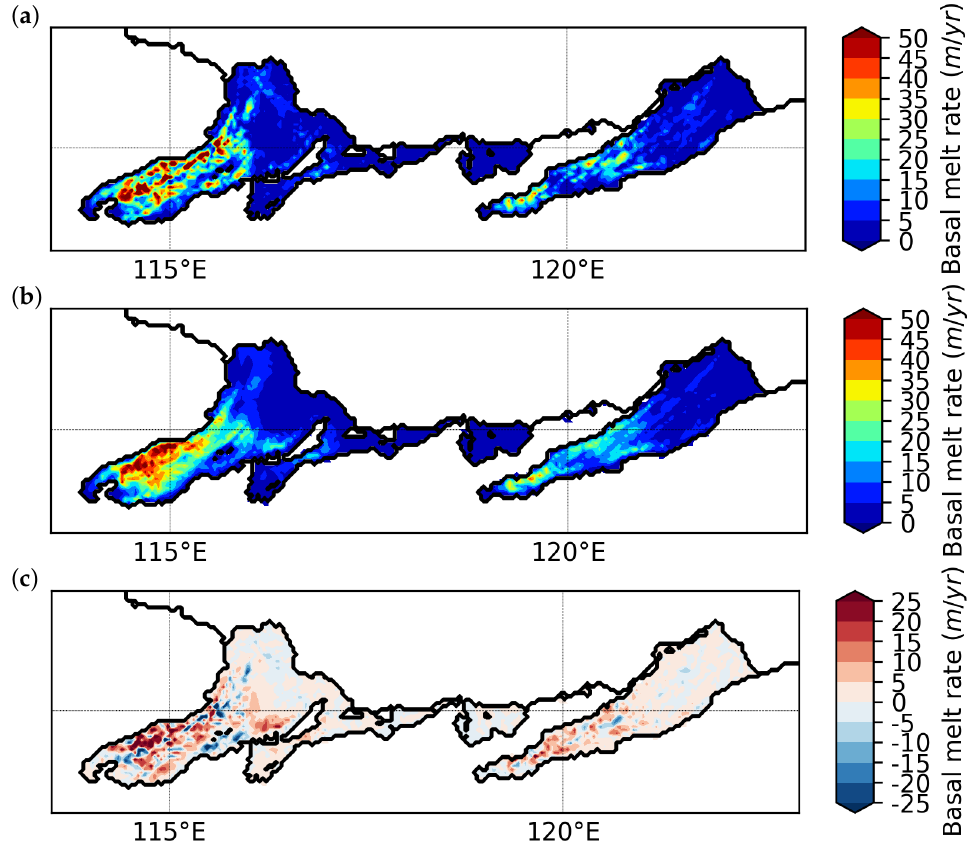
Figure 4. Spatial distributions of the mean basal melt rate for the REF ( a ) and REF3mcpl ( b ) simula- tions over the 1995–2014 period. Differences in basal melt rate between REF3mcpl and REF, averaged over the 1995–2014 period ( c ).